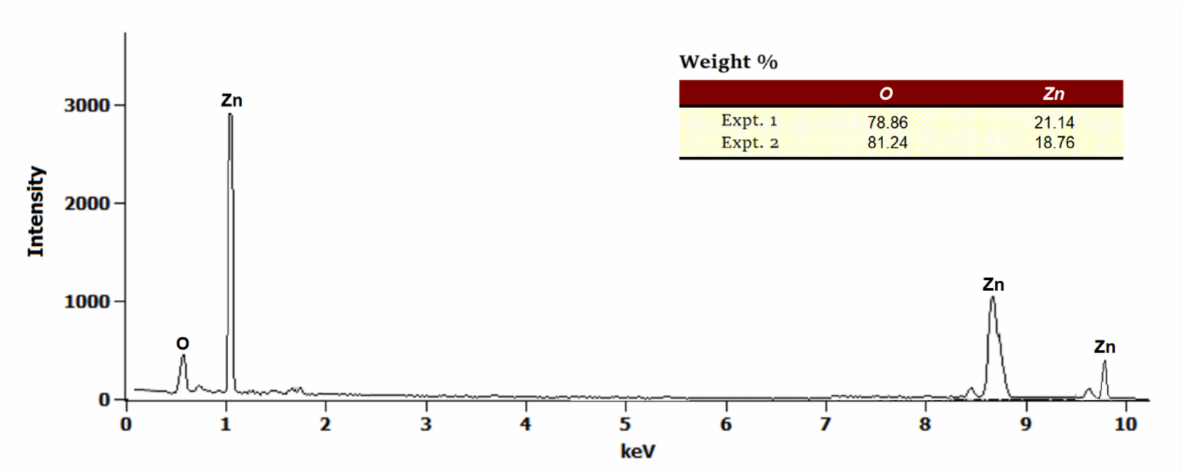
Figure 4. Energy dispersive X-ray spectrum of chitosan − ZnO (20